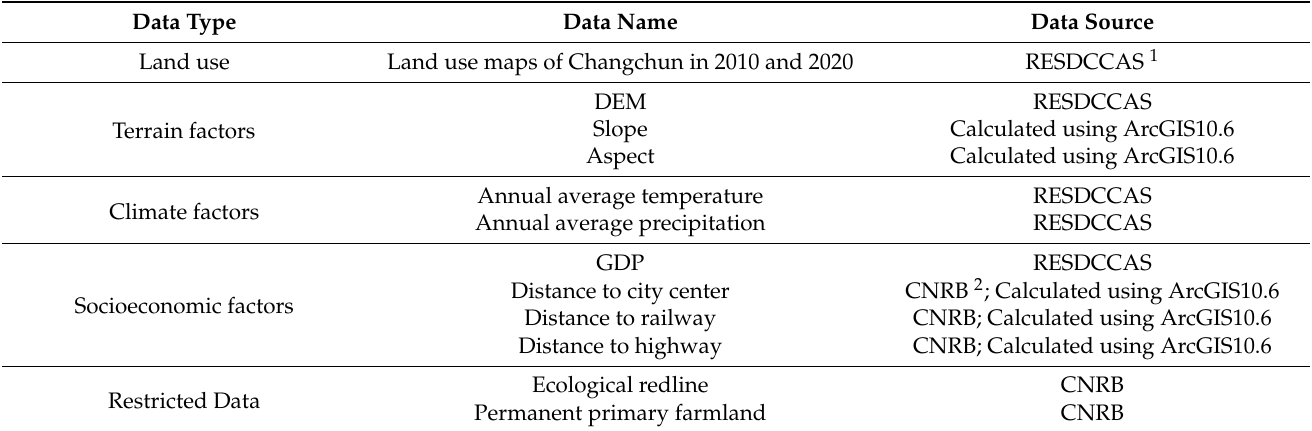
Table 1. Data source.